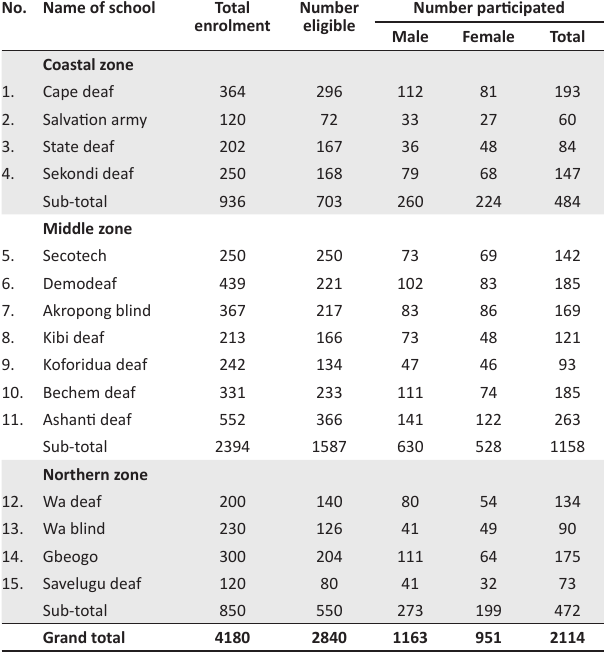
TABLE 1: Distribution of study participants by sampled special